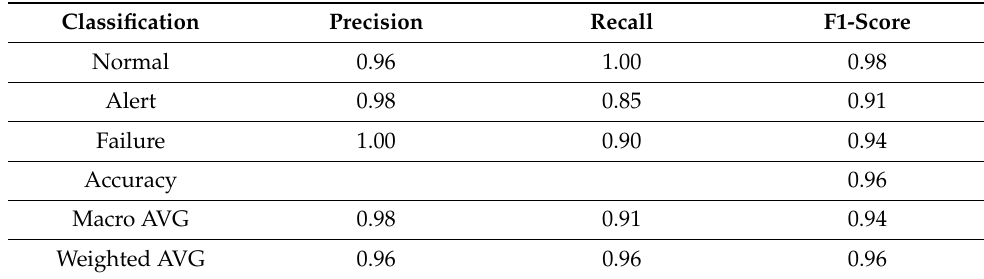
Table 3. Classification of the lubricating oil results.